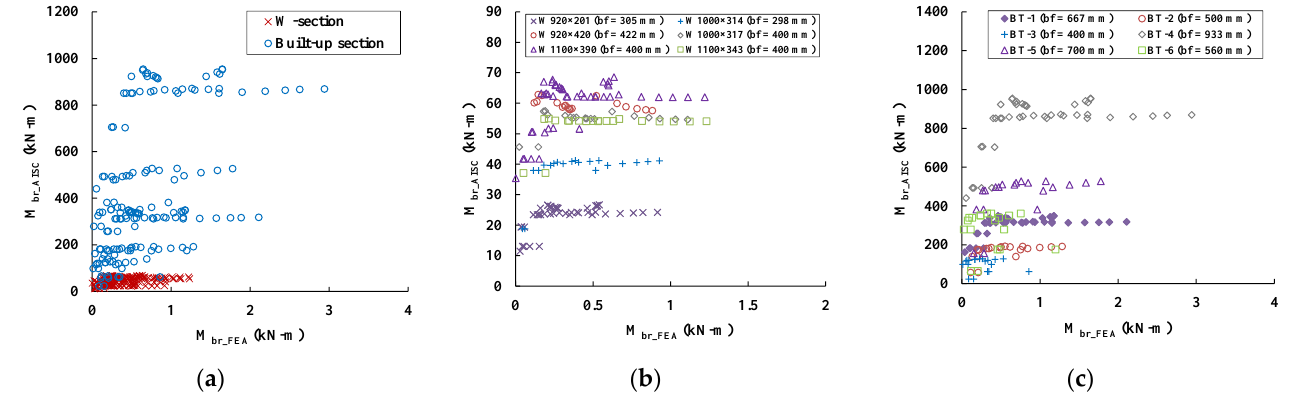
Figure 7. Comparisons between bracing moments of design provision and FEA: ( a ) cross-section types; ( b ) W-sections; and ( c ) built-up sections.